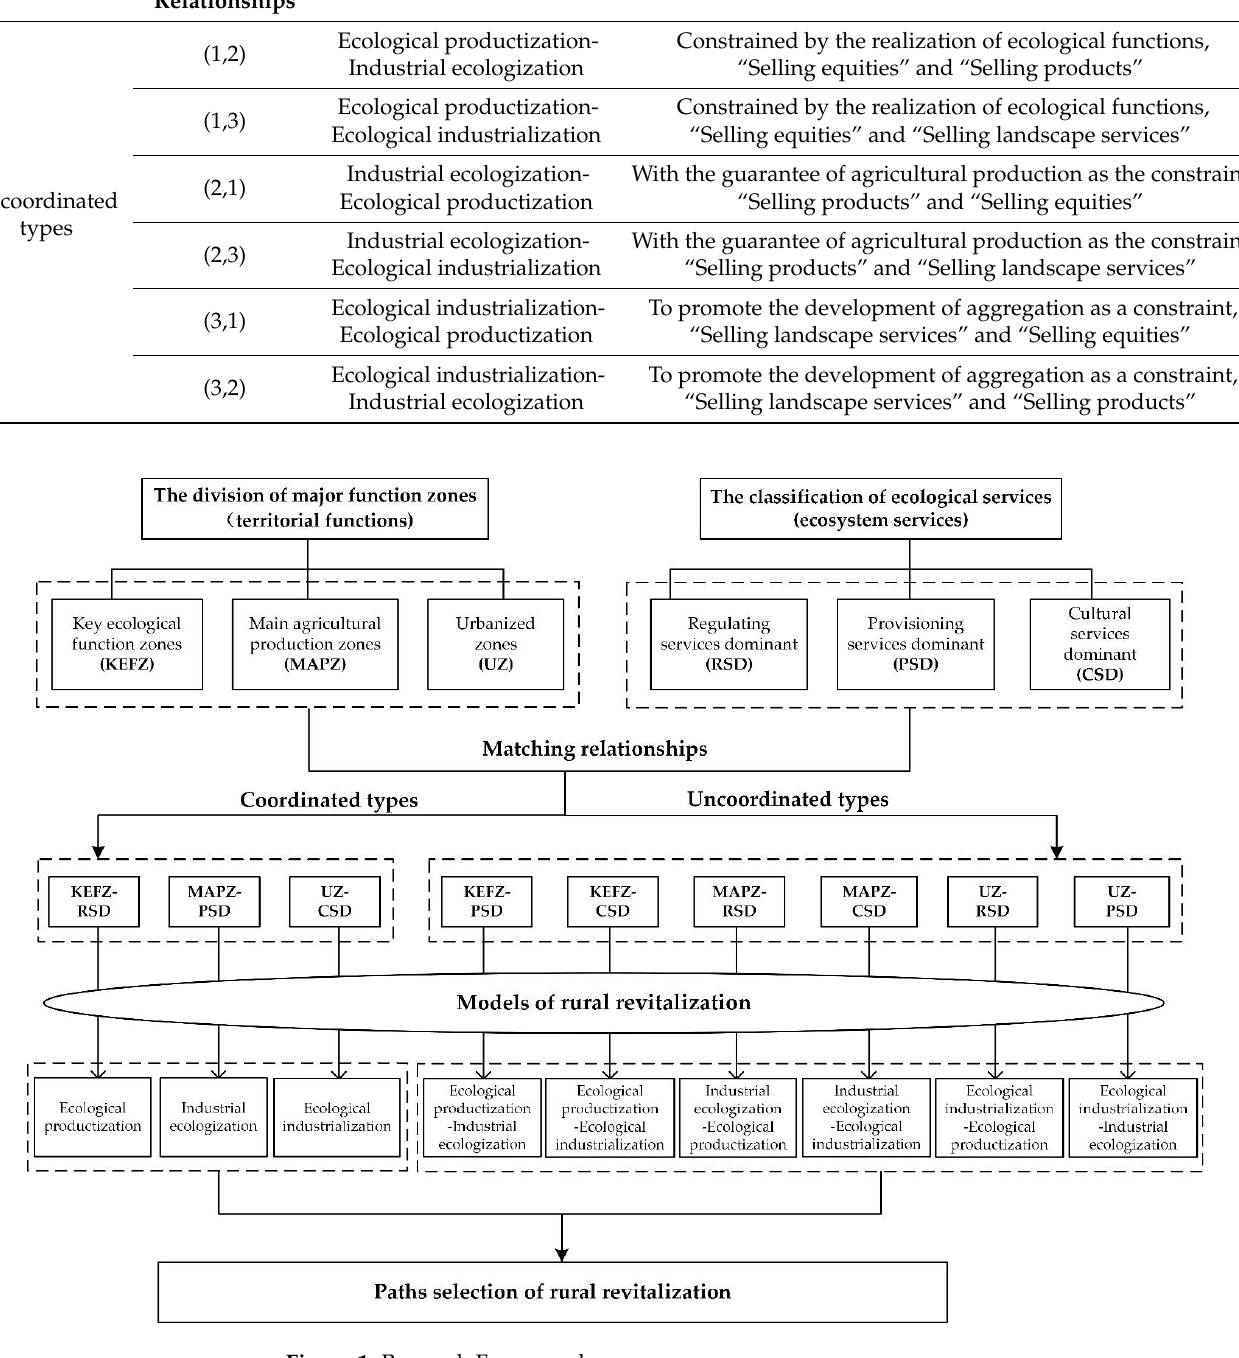
Figure 1. Research